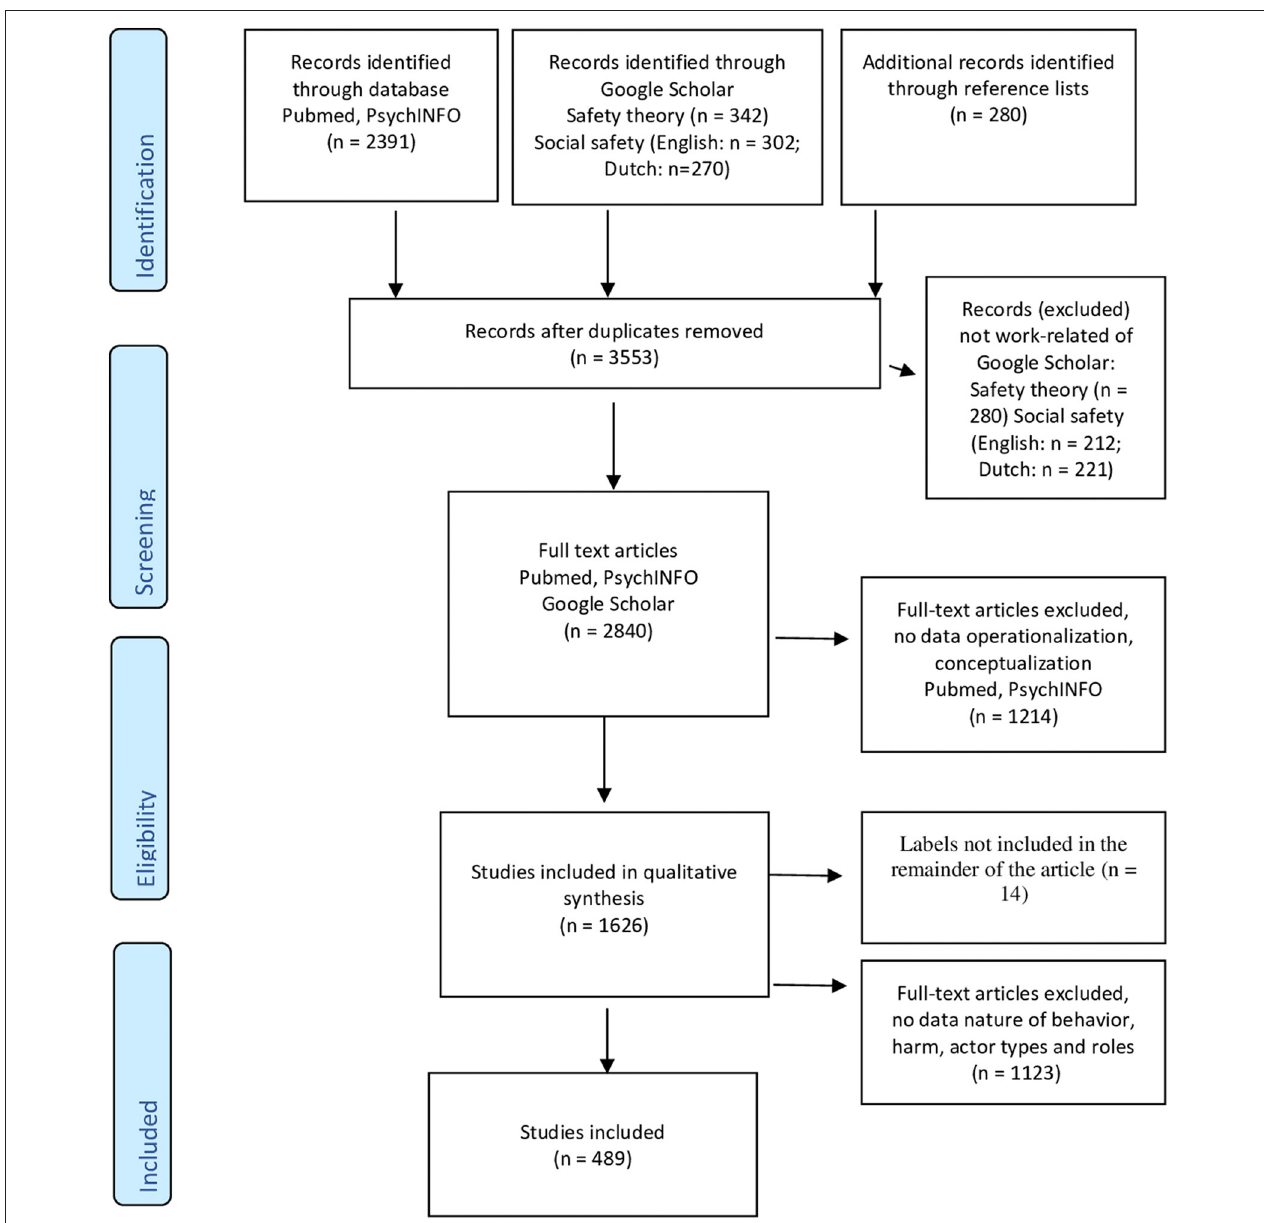
FIGURE 1 | Systematic review of negative work behavior (NWB) in a Preferred Reporting Items for Systematic Reviews and Meta-Analyses (PRISMA) flow